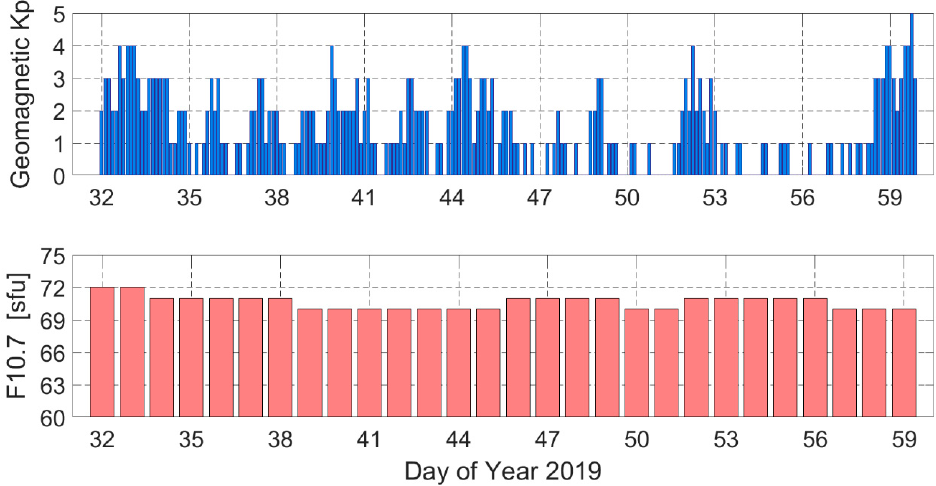
Figure 2. Geomagnetic Kp index and F10.7 values on 1–28 February 2019. Table 1. Adopted models and strategies for multi-GNSS single-frequency SPP/PPP .